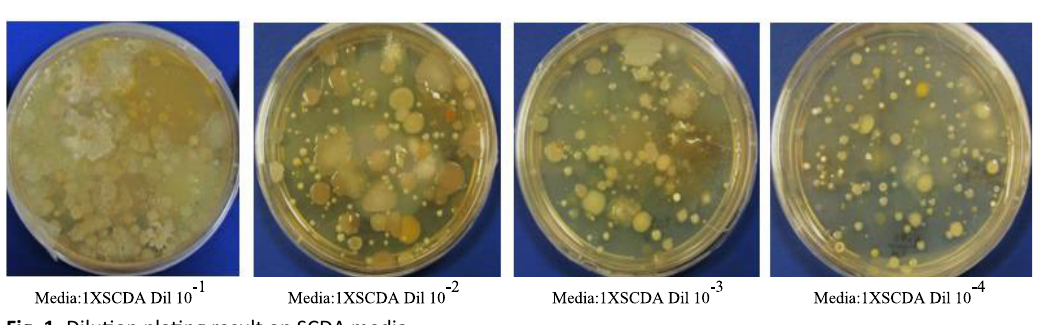
Fig. 1. Dilution plating result on SCDA media